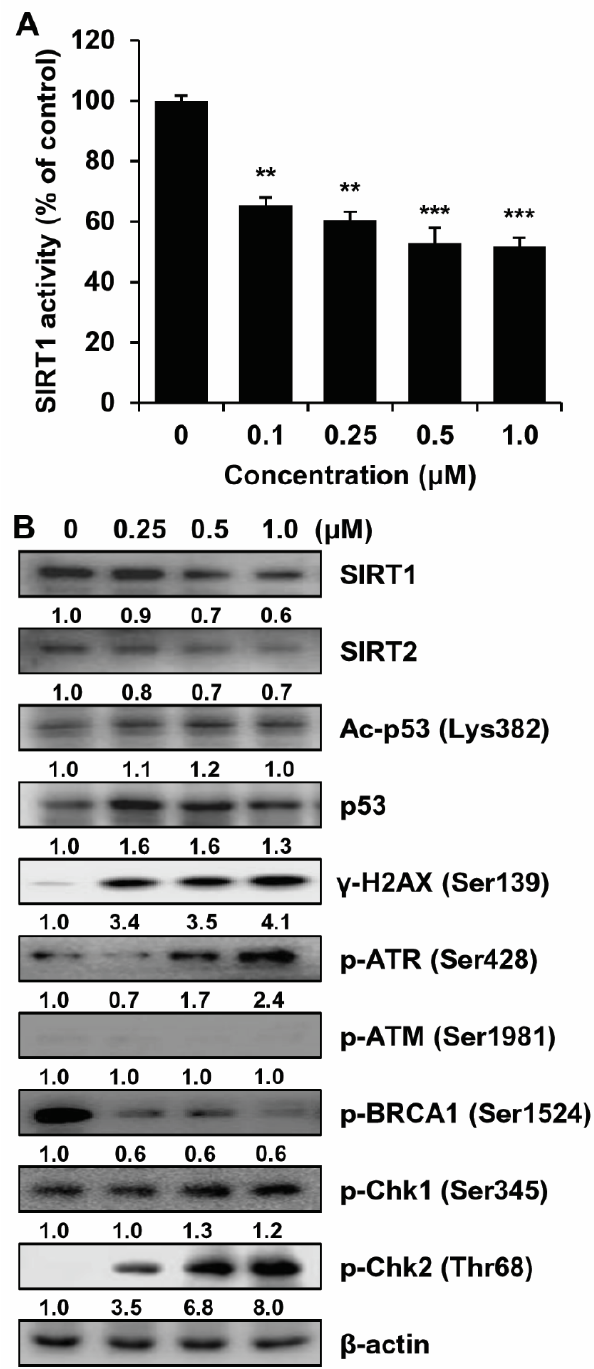
Figure 4. Effect of MHY2245 on SIRT and the expression of DNA damage response mediators and effector cascade in HCT116 cells. ( A ) Graph showing SIRT1 activity. Results are presented as mean ± SD, n = 3, and are expressed as a percentage of SIRT1 activity in vehicle-treated control cells. ** p < 0.01 and *** p < 0.001 compared with vehicle-treated control cells. ( B ) Cells were treated with the indicated concentrations of MHY2245 for 24 h and Western blot analyses were conducted to investigate the expression of SIRT1, SIRT2, Ac-p53 (Lys382), p53, γ -H2AX (Ser139), p-ATR (Ser428), p-ATM (Ser1981), p-BRCA1 (Ser1524), p-Chk1 (Ser345), and p-Chk2 (Thr68). β -actin was used as a loading control. Representative results from three independent experiments are shown.